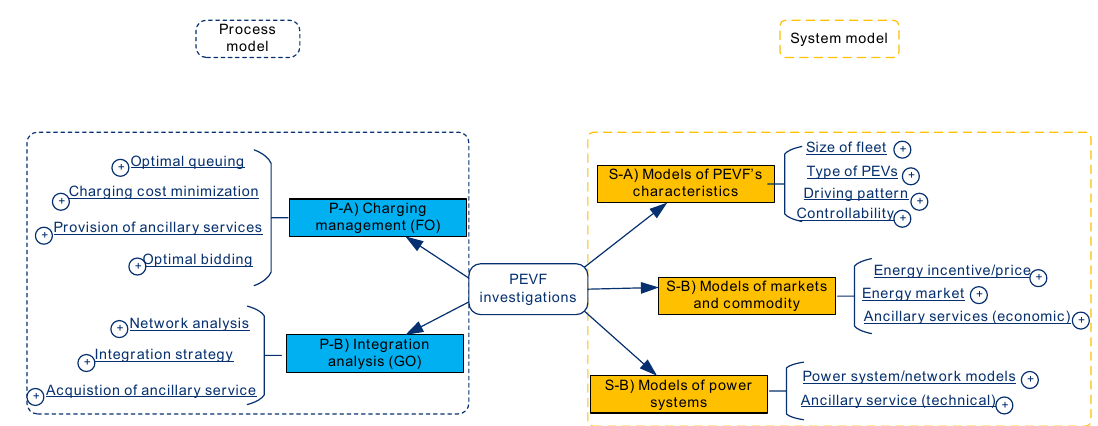
Figure 2. An abstracted overview of process models vs. system models ( + denotes further extension is possible).